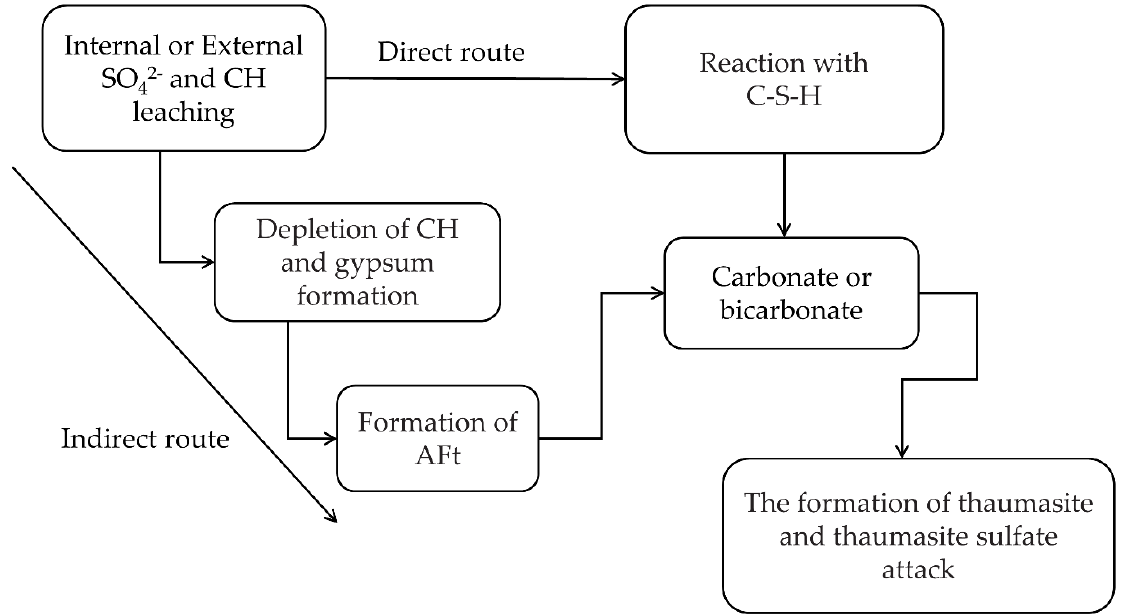
Figure 10. A simplified diagram for the direct and indirect routes of the formation thaumasite and thaumasite sulfate attack [221].